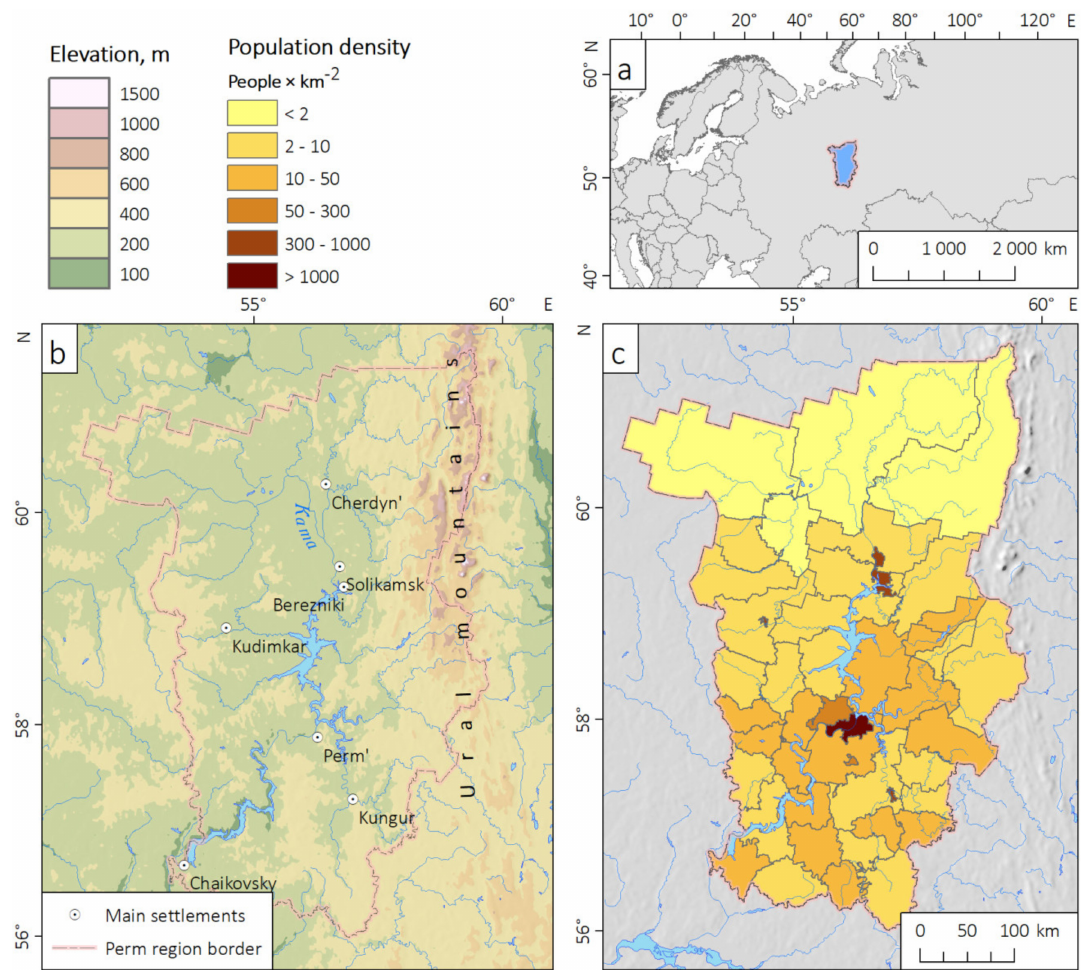
Figure 1. Main characteristics of the Perm region: ( a ) geolocation, ( b ) topography, and ( c ) population density calculated for municipal